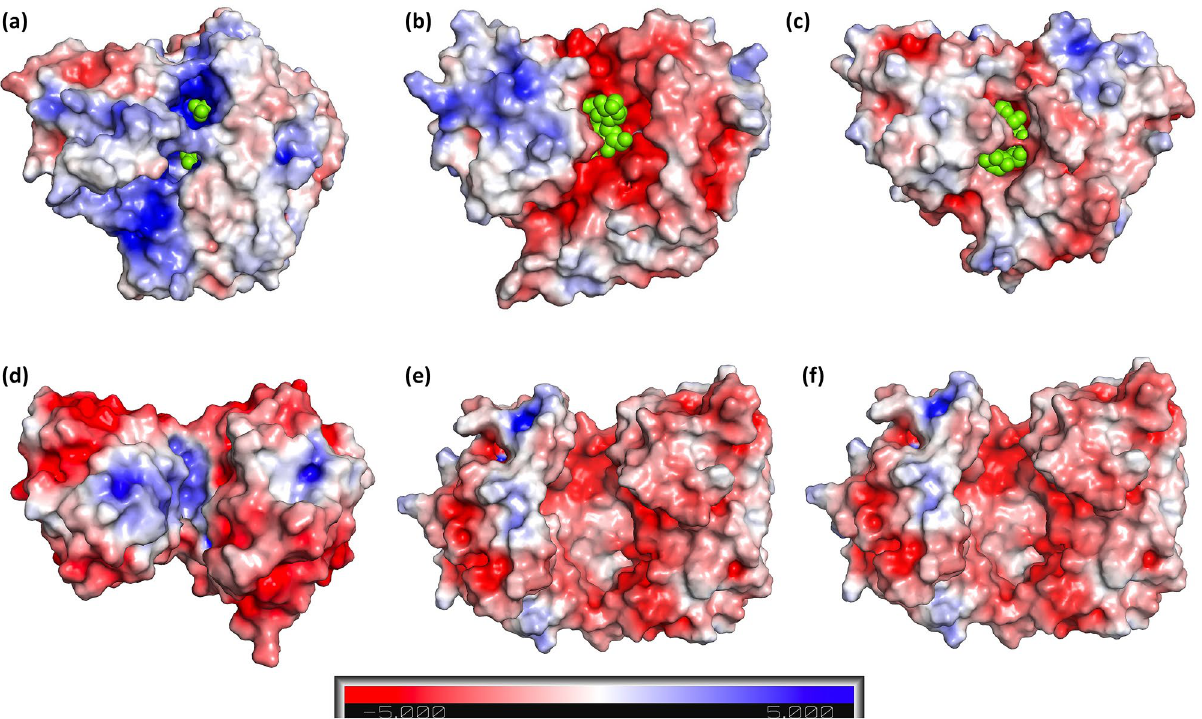
Figure 5. Comparison of binding cleft chemistries for MsBP relatives. The APBS electrostatic surface representation 68 of Zn-MsBP (6WPM) is shown in (a) highlighting the unique positively-charged binding cleft . Structurally related sugar-binding proteins (b) SO-BP (PDB ID: 5YSE) 37 , (c) GacH (PDB ID: 3K00) 36 , (d) anion- binding protein ModA (PDB ID: 3K6V) 41 , (e) metal-mediated fructooligosaccharide-binding protein(FusA) from S. pneumoniae (PDB ID 5G5Y) 69 , and (f) the chitin-binding protein (CBP) from marine Vibrio sp. (PDB ID 5YQW) 70 are presented for comparison. All proteins are shown looking directly on the binding cleft with charge coloured at the same scale. Ligands (b–c) and bound sulphate ions (Zn-MsBP) are shown as green spheres. Blue corresponds to a positive surface charge; red corresponds to a